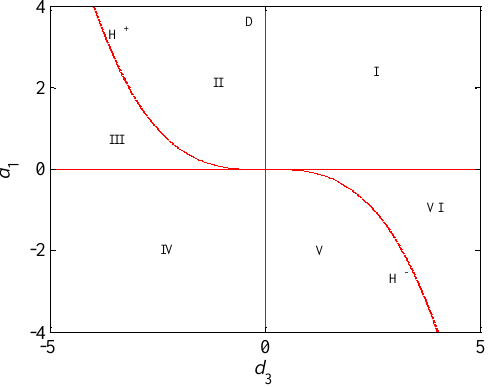
Figure 18. Transition set of a nonlinear coupled vibration system of hot rolling mill rolls with d 2 = 0. (3) When d 3 = 0, the bifurcation equation is u 4 + λ + d 1 u + d 2 u 2 = 0, bifurcation point (cid:26)(cid:16) (cid:17) 2 (cid:16) (cid:17) 3 (cid:27) d 1 d 2 = − set B = φ , hysteretic point set H = , double limit point set D = { d 1 = 0, 8 8 d 2 ≤ 0}, and transition set Σ = B ∪ H ∪ D . Figure 20 shows the transition set of the coupled vibration system. Figure 21 shows the corresponding bifurcation topology. The unfolding plane is divided into four regions, and eight bifurcation modes are given. The rolling mill is in a stable state on the curve of origin O, I, IV, and double limit point set D; in the other regions, the jump phenomenon